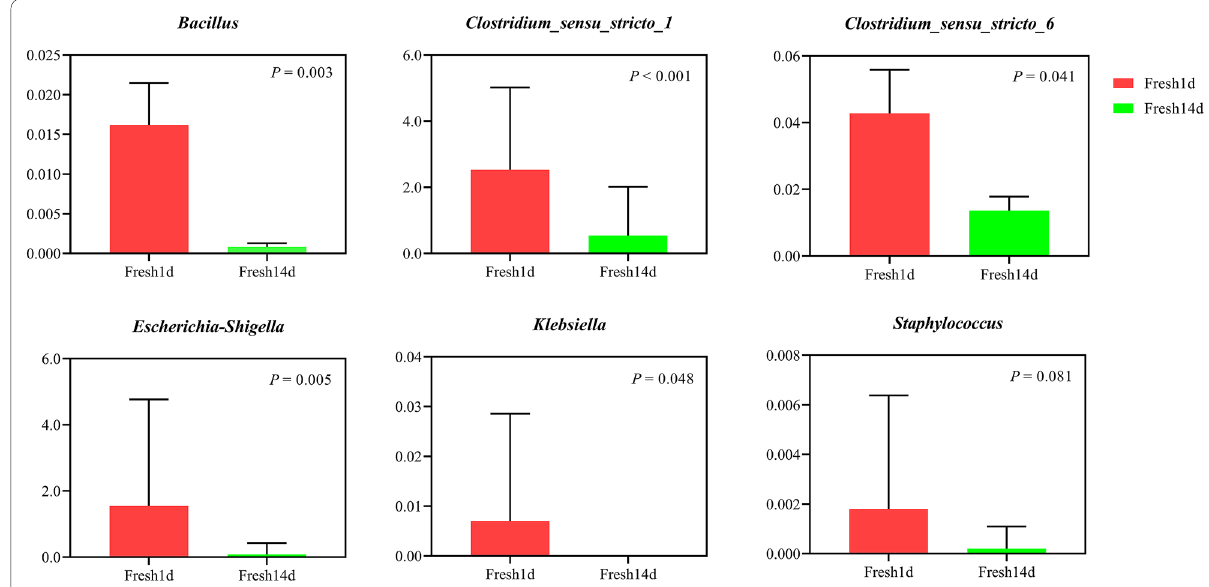
Fig. 3 The barplot of the relative abundance of potentially pathogenic bacteria in dairy cows during early lactation. Fresh1d indicates fecal microbiota samples from cows on d1, Fresh14d indicates fecal microbiota samples from cows on